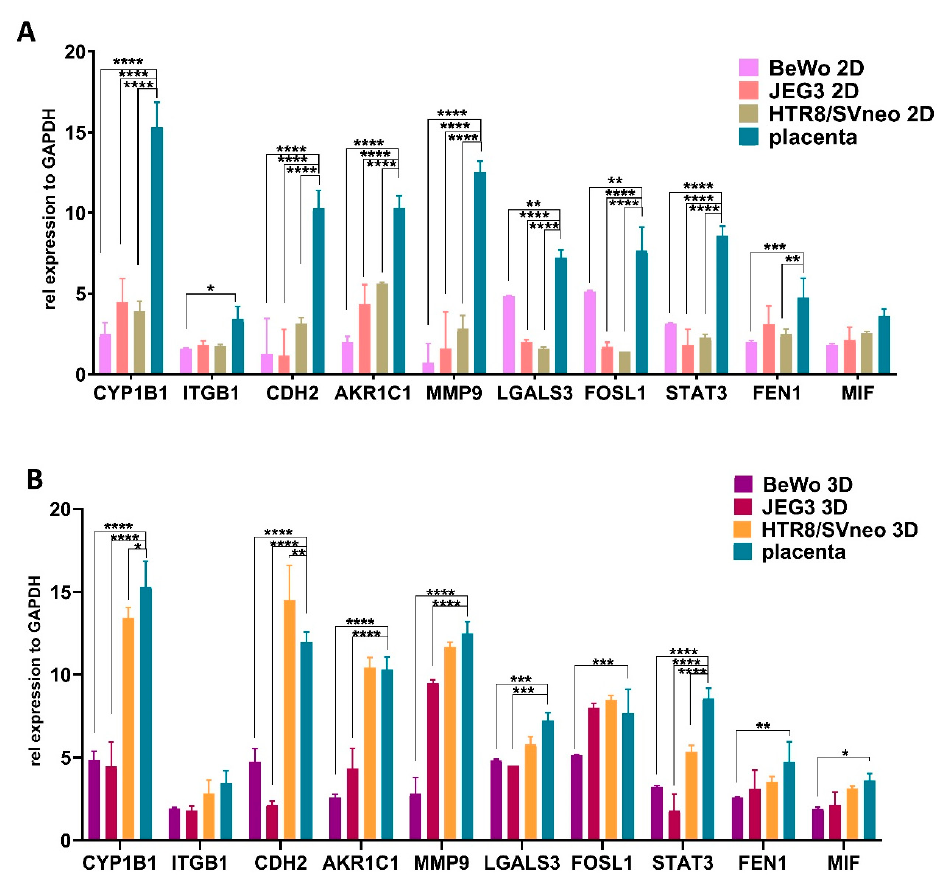
Figure 6. Gene expression profiles in trophoblast spheroids. Comparison of gene expression levels of cytochrome p450 gene CYP1B1; cell adhesion markers CDH2 and AKR1C1; cell invasion markers MMP9, LGALS3, FOSL1 and MIF; DNA damaging factor FEN1 and the transcriptional factor STAT3 between 2D cell cultures of BeWo, JEG3 and HTR8/SVneo cell lines ( A ) and respective 3D spheroids ( B ) with first trimester placenta tissue. * p < 0.05; ** p < 0.01; *** p < 0.001; **** p < 0.0001.